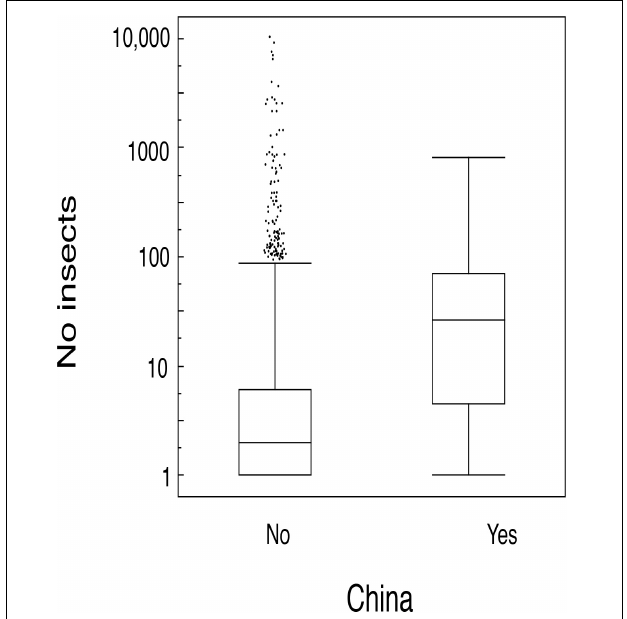
FIGURE 4 | Box plots of the number of insects sampled with a car in China and Europe. The box plots show median, quartiles, 5- and 95-percentiles and extreme values. Observations are jittered to make observations